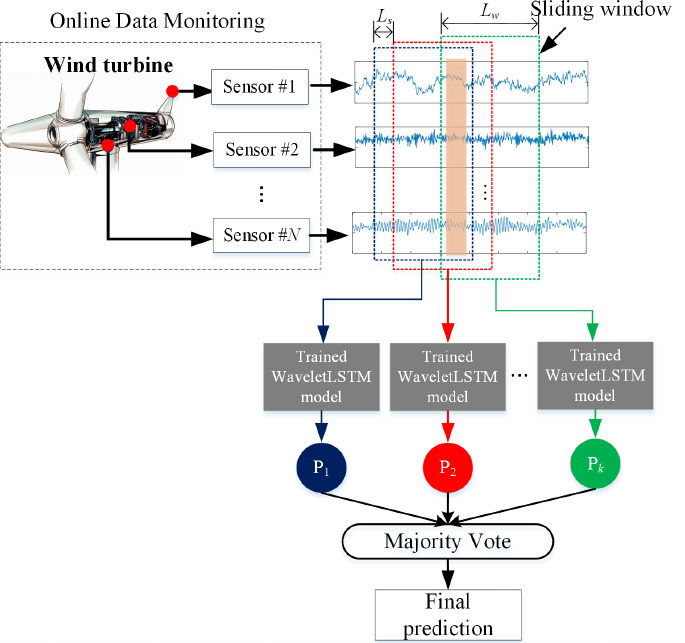
Figure 4. Online detection based on the sliding window and the majority